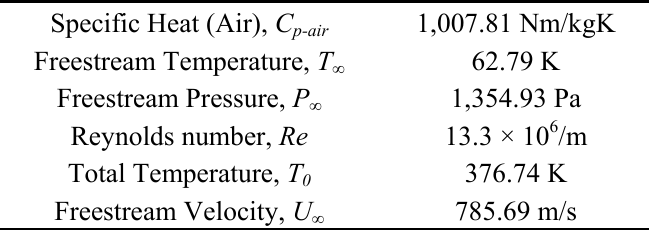
Table 2. HSST flow condition during infrared thermography experiment measured directly from the wind tunnel.